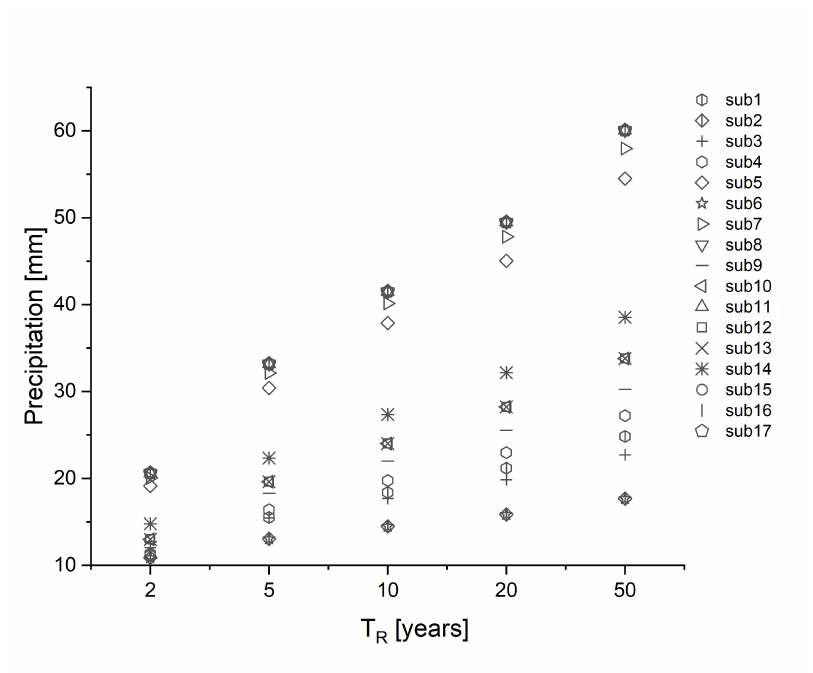
Figure 7. Maximum daily precipitations for a return period T R of 2, 5, 10, 20, and 50 years for each subbasin. Results are obtained upon interpreting rainfall data through the GEV distribution (Equation